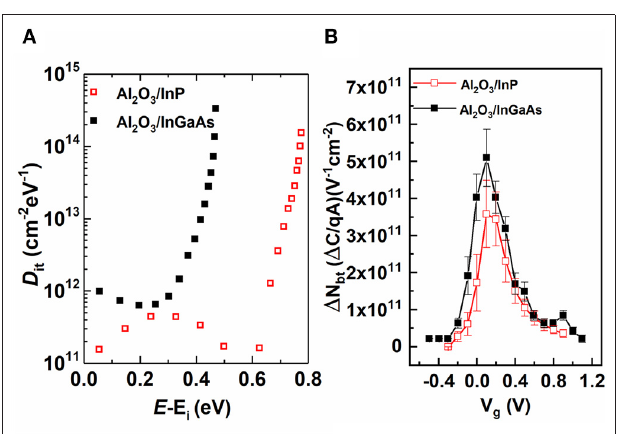
FIGURE 3 | Distribution curves of (A) the interface and (B) border trap densities of Al 2 O 3 /InGaAs and Al 2 O 3 /InP capacitances extracted from the multifrequency C-V measurement, respectively.